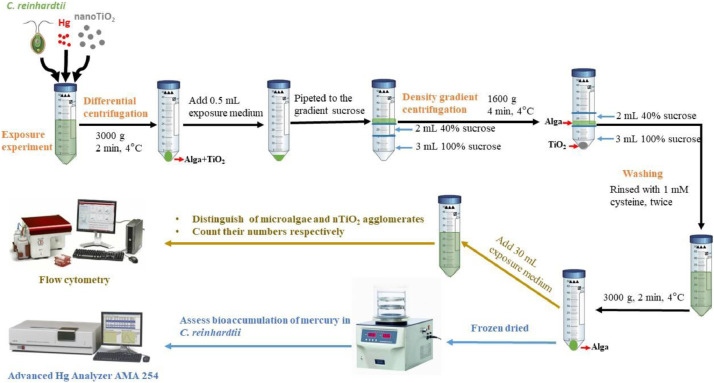
Summary of developed procedure for separation of algal cells from nanoTiO2 and TiO2 aggregates using density gradient centrifugation.